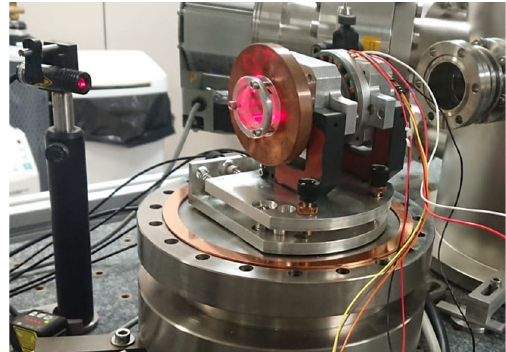
Fig. 4 A photograph of the rotation stage prototype. The optical ele- ment is fastened at the near end of the